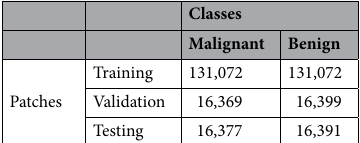
Table 4. Information about the number of patches in each data split for PatchCamelyon.